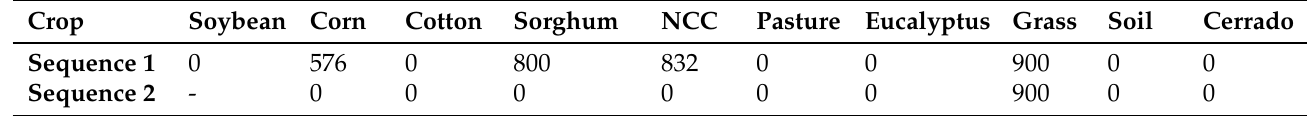
Table 1. Amount of synthetic patches created per selected classes (soybean, corn, cotton, sorghum, non-commercial crops (NCC), pasture, eucalyptus, grass, soil, and Cerrado) by using horizontal and vertical translations. Crop Soybean Corn Cotton Sorghum NCC Pasture Eucalyptus Grass Soil Sequence 1 Sequence